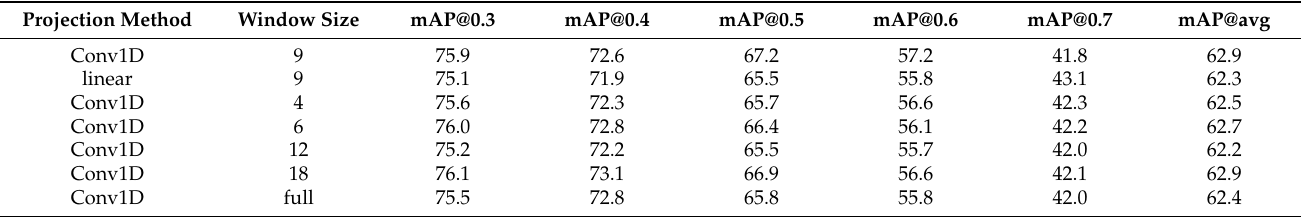
Table 4. Ablation study on the window size in WSA. We report the mAP at tIoU from 0.3 to 0.7 and the average mAP in [0.3,0.4,0.5,0.6,0.7] on THUMOS14.